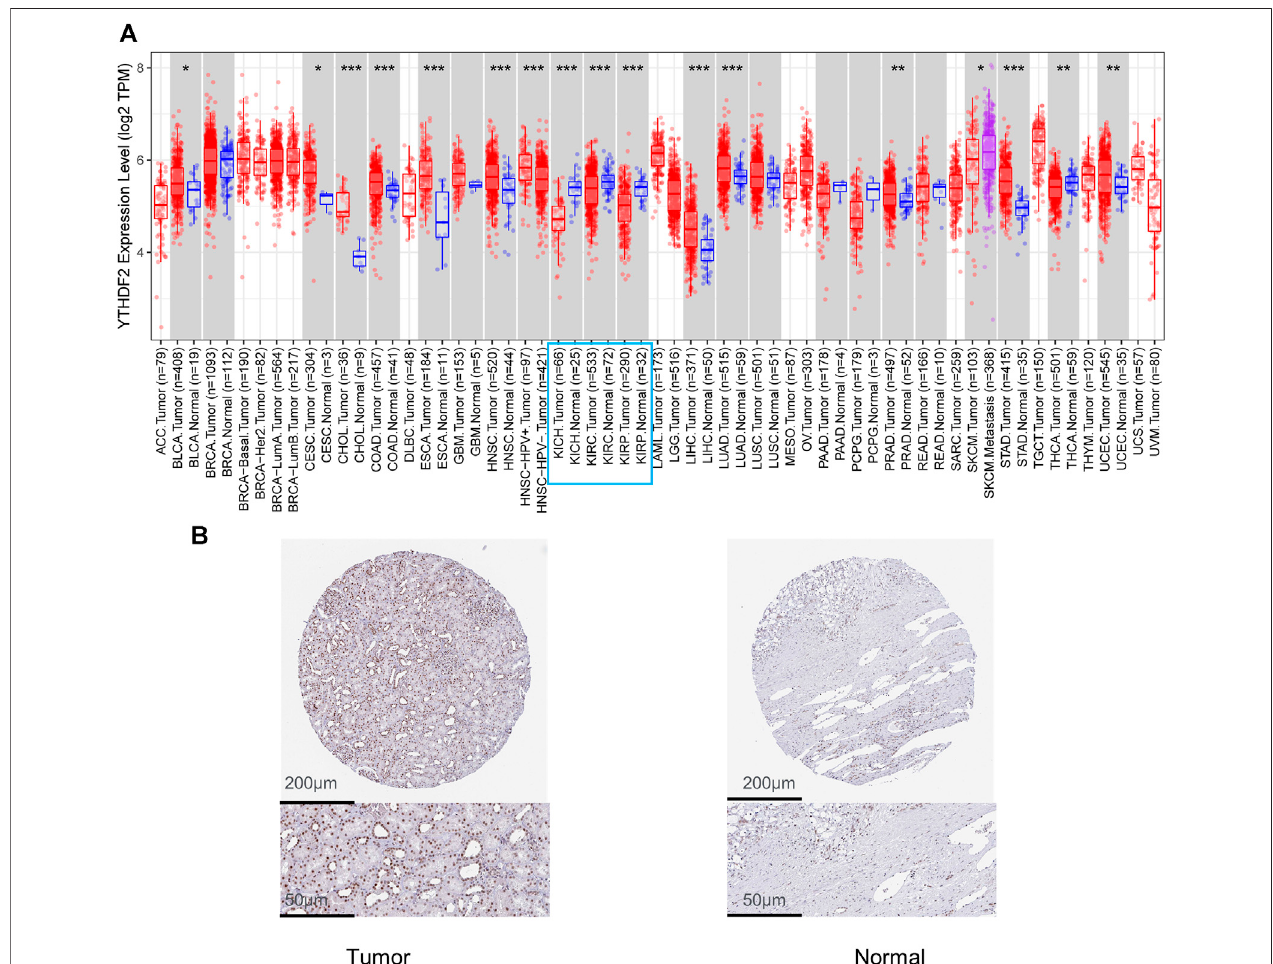
FIGURE 1 | Expression level of YTHDF2 in renal clear cell carcinoma (KIRC). (A) YTHDF2 levels were shown to be higher or lower in various cancers in the TCGA database (TIMER). (B) Protein expression of YTHDF2 in KIRC. KIRC, Kidney renal clear cell carcinoma.